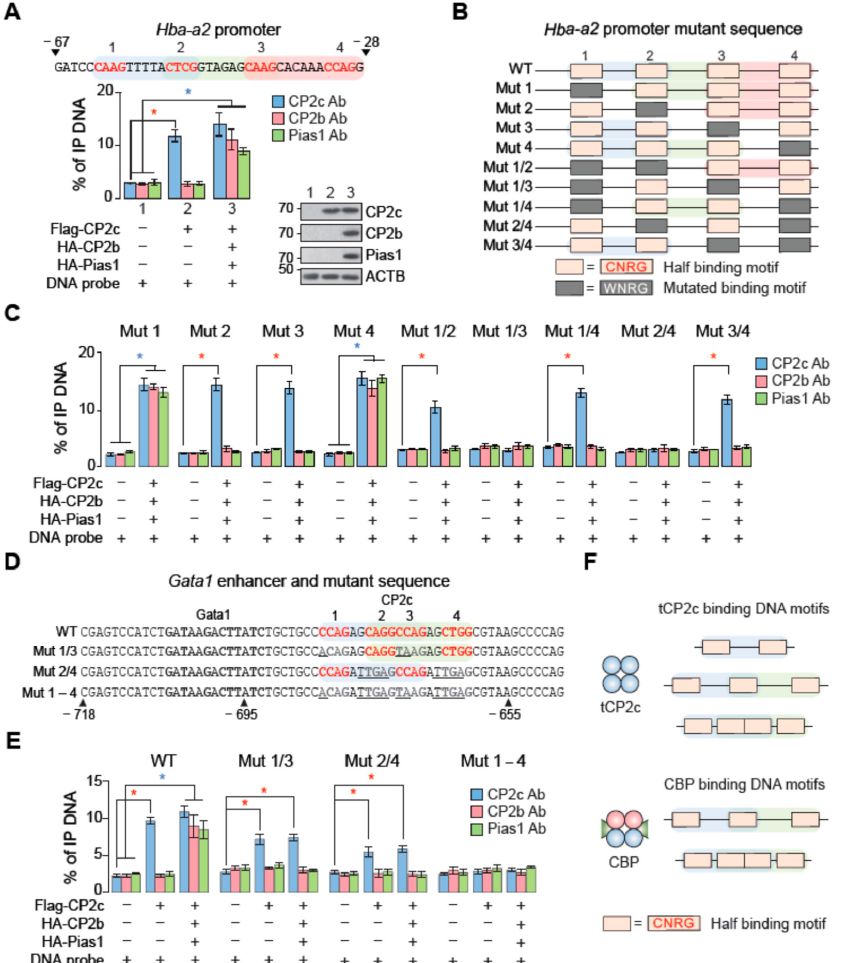
Figure 2. tCP2c binds to sequences containing two consecutive CP2c half-sites, whereas CBP binds to sequences containing three consecutive CP2c half-sites or two staggered CP2c binding motifs. ( A – C ) Dissection of minimal CP2c binding motifs for the binding of tCP2c and CBP complexes in the Hba-a2 promoter. ( A ) CP2c binding motifs in the Hba-a2 promoter (top) and DIP profiles